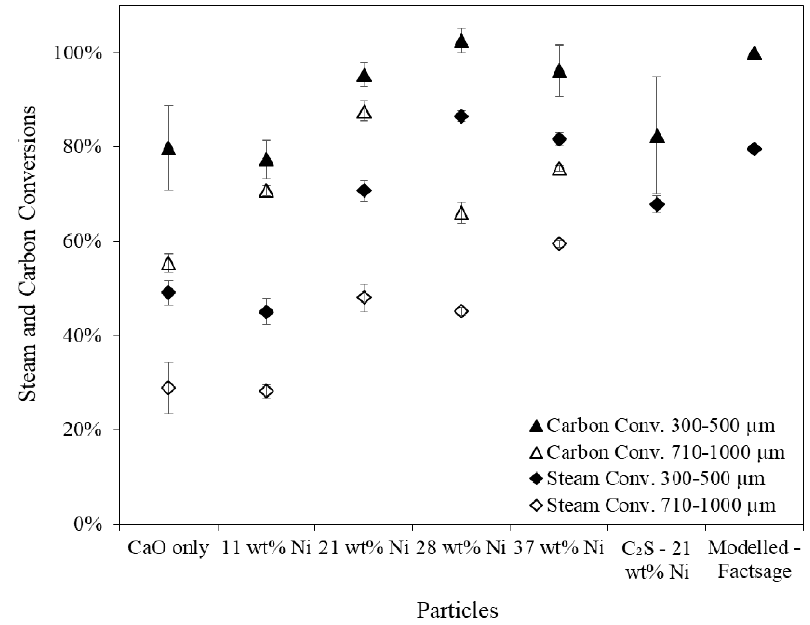
Figure 9. Steam and carbon conversions over the whole Sorption Enhanced Steam Reforming (SESR) reaction period, whereby the carbon conversions include the CO 2 released during the calcination stage. SESR of biomass in a fluidised bed reactor with varying compositions of combined particles.